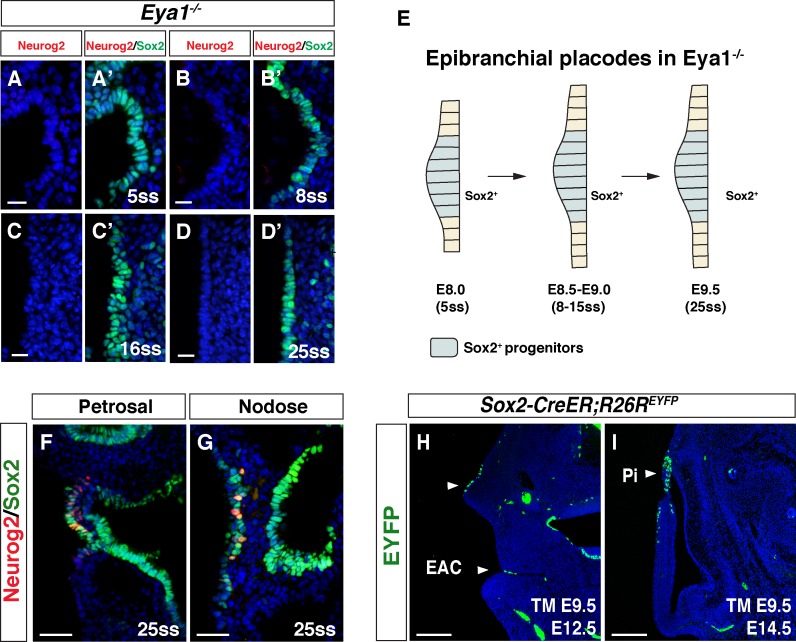
Analysis of bipotential Sox2+ progenitors of the neurogenic and non-neuronal lineages in the epibranchial placodes.(A–D’) Co-immunostaining for Neurog2/Sox2 on transverse sections of WT at 5ss and of Eya1-/- embryos at 5ss, 8ss, 16ss and 25ss (n = 3/stage). (E) Schematic diagram showing the development of Sox2+ epibranchial placode progenitors in Eya1-/- embryos. Sox2 progenitors (blue) remain present in the pharyngeal ectoderm of Eya1-/- embryos. (F and G) Co-immunostaining for Neurog2 and Sox2 on transverse sections of wildtype embryos at the petrosal and nodose placodal regions at E9.5. Sox2+ and Neurog2+ cells were intermingled at the placodal regions at 25ss (n = 5). (H and I) Lineage tracing of Sox2+ placodal cells in Sox2-Cre; R26REYFP embryos. Tamoxifen was injected at E9.5 and embryos were examined by immunostaining of EYFP at E12.5 (H) and E14.5 (I) (n = 3). Arrowheads indicate the EYFP+ cells. EAC, external auditory canal; Pi, pinna. Scale bars, 20 µm (A–D’) and 100 µm (H–I).